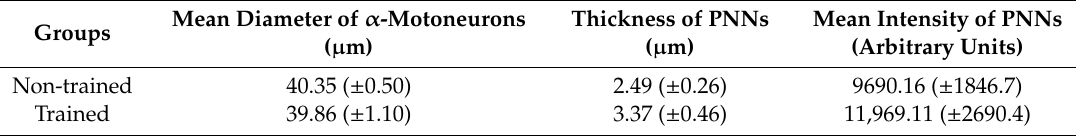
Table 2. Thickness and staining intensity of perineuronal nets around